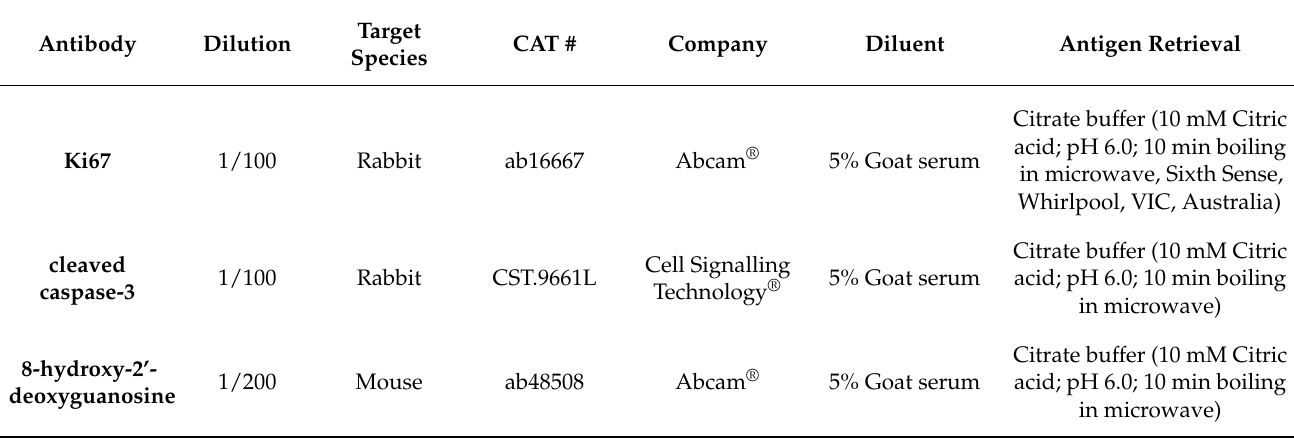
Table 1. Antibodies used for immunohistochemical